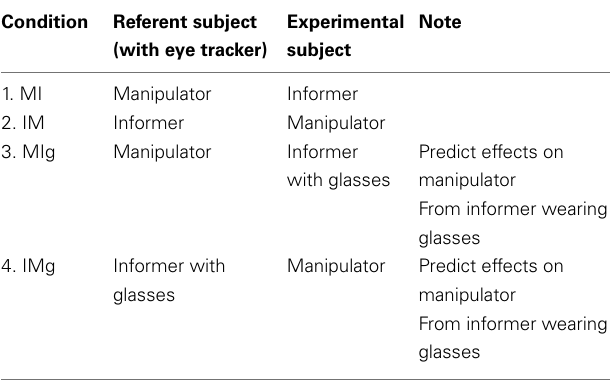
FIGURE 2 | Common timeline of the experiments. The task is composed of four phases. Instruction phase: from the confidential instruction provided by the program (via the headphone to the manipulator) to the beginning of the label verbalization (a). Search phase: from the beginning of the label verbalization by the manipulator (a), the informer hearing (b), and then searching for (c) the cube, to the beginning of the location verbalization by the informer (e).The location phase: from the label verbalization by the informer